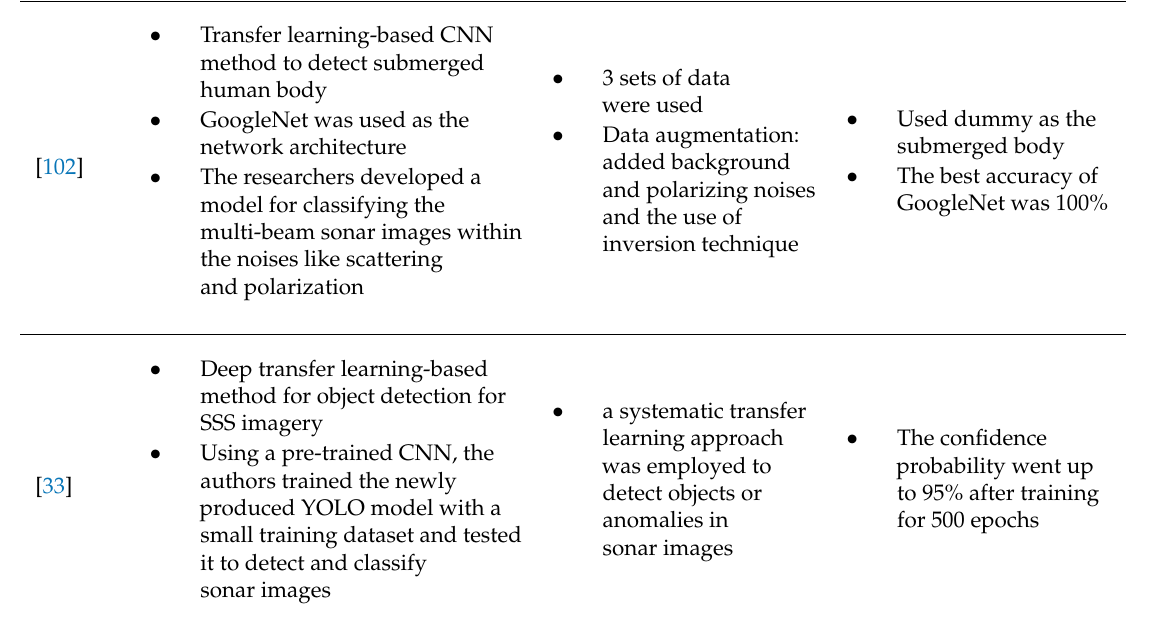
Table 2. The tabular analysis of the transfer learning-based DL algorithms reviewed in this article. A.